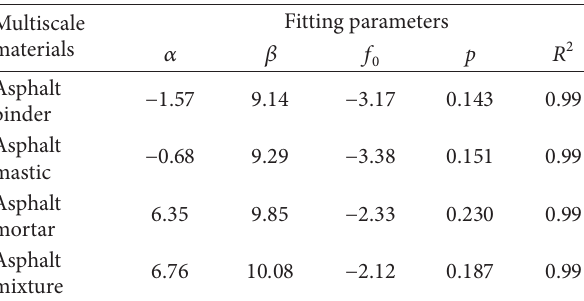
Table 4: Fitting parameters of the master curves.